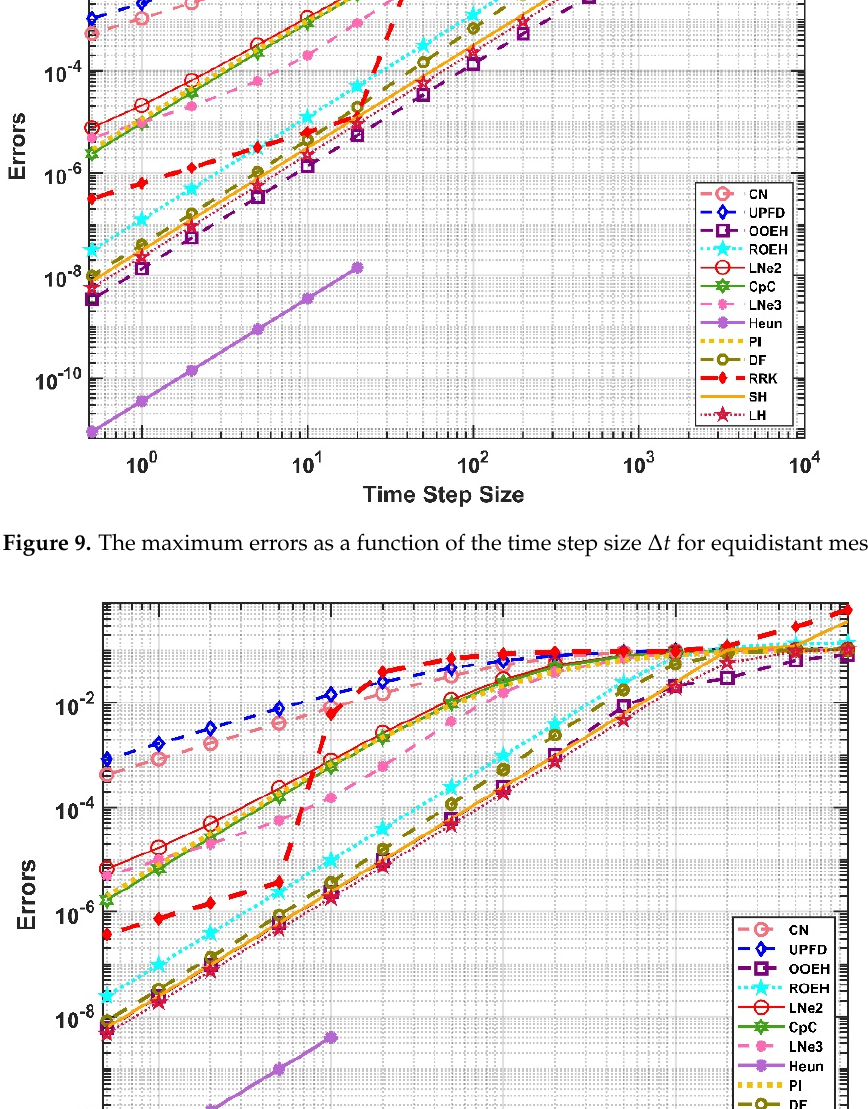
Figure 10. The L ∞ errors as a function of the time step size ∆ t in case of abrupt change in the x -direction and gradual change in the z -direction.